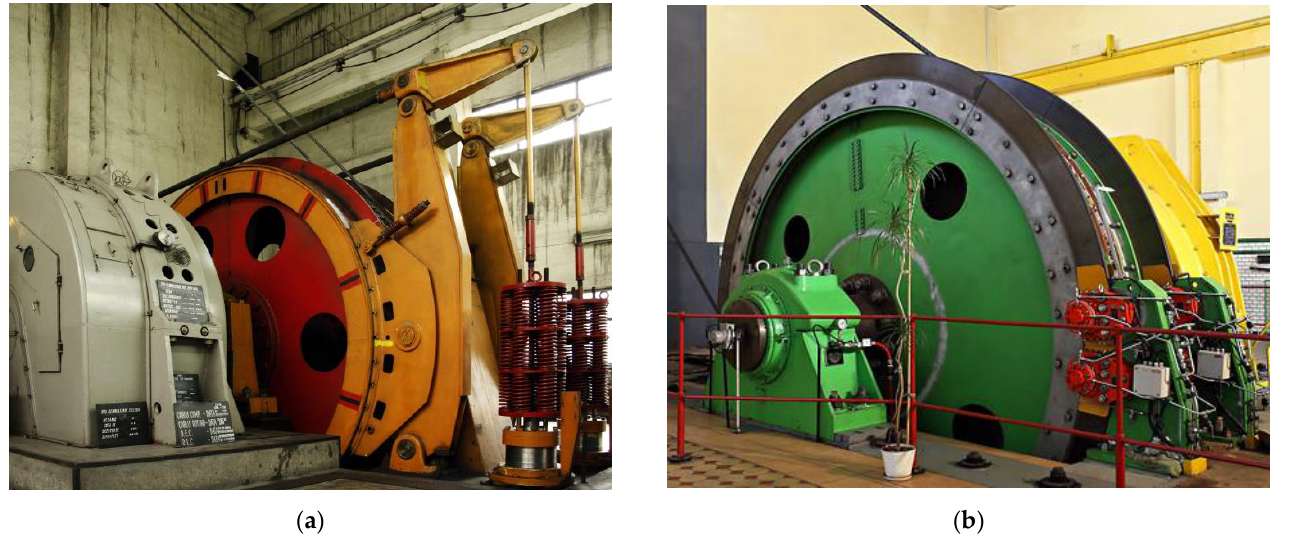
Figure 2. Types of brakes used in mine hoisting systems: ( a ) drum-and-shoe brake system; ( b ) disc-and-pads brake